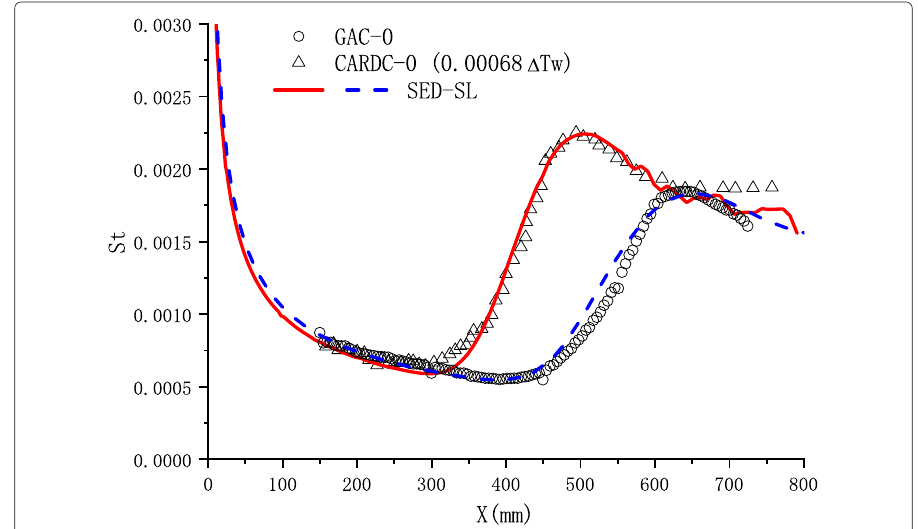
Fig. 9 The St distributions along the meridian line computed by the SED-SL model for the GAC-0 and CARDC-0 cases, compared with the experimental data. For the CARDC-0 case, the experimental data are the rescaled surface temperature